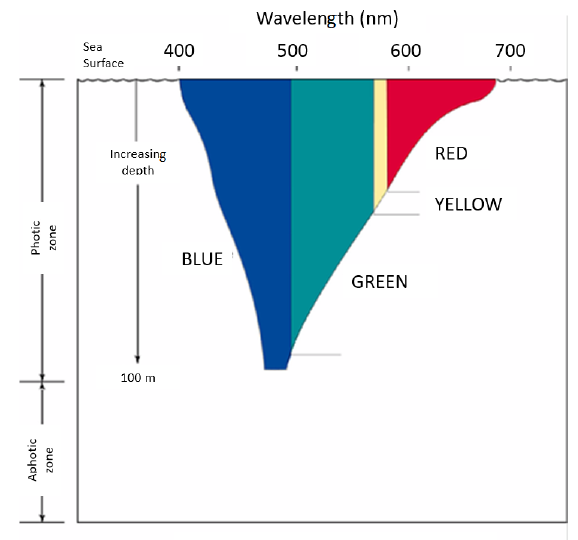
Figure 1. Light absorption in